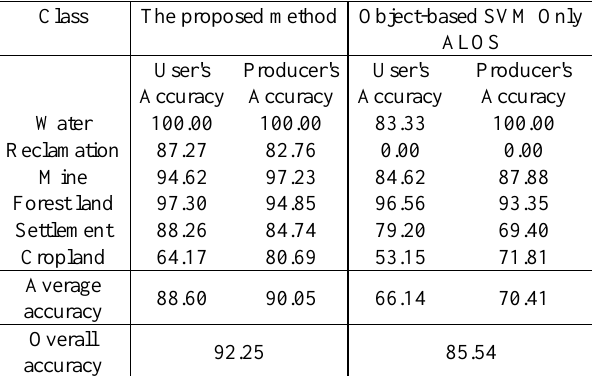
Table 1. Producer, user and overall classification accuracies for